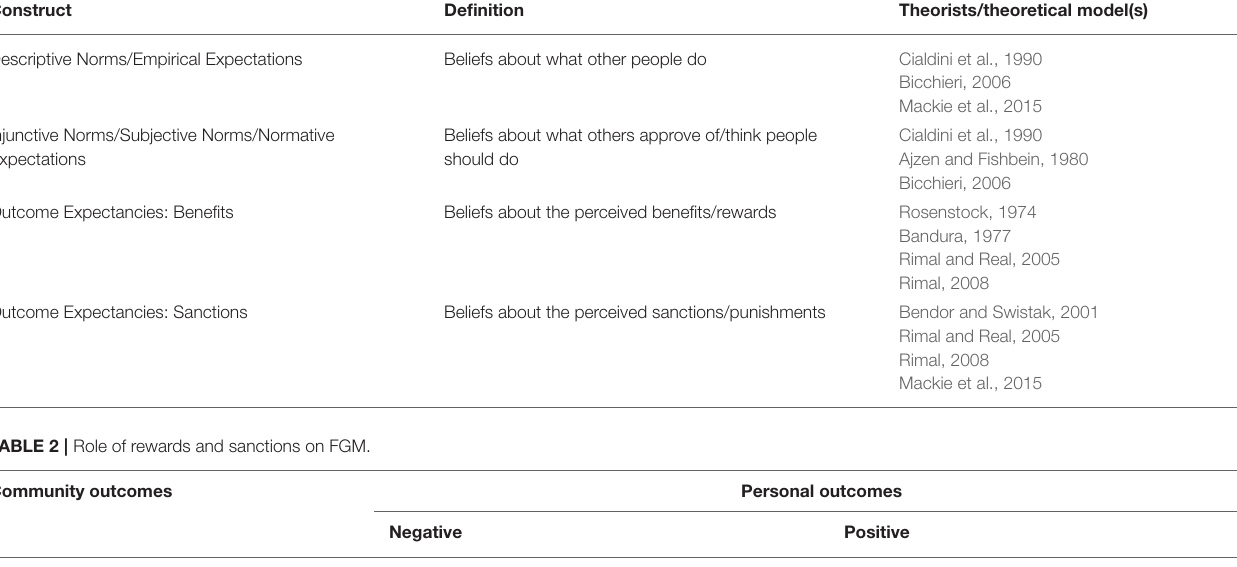
TABLE 1 | Summary of social norms constructs.